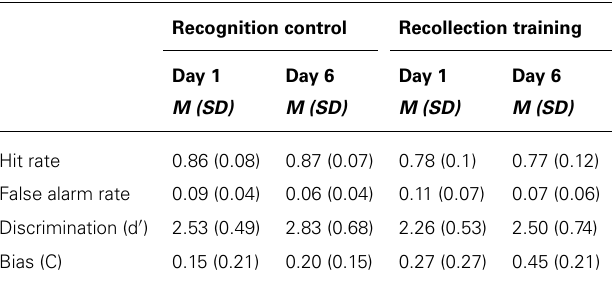
Table 2 | Hit and false alarms rates, and discrimination index (d (cid:2) ) and response bias (C) at Day 1 and Day 6 of training. Recognition